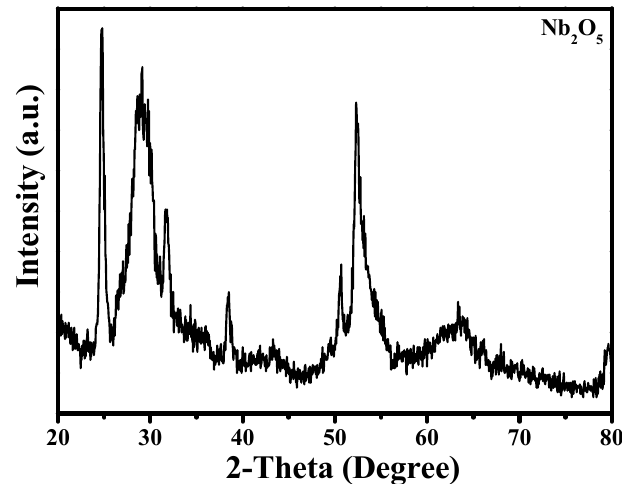
Figure 1. XRD patterns of the as-prepared Nb 2 O 5 micro-flower.